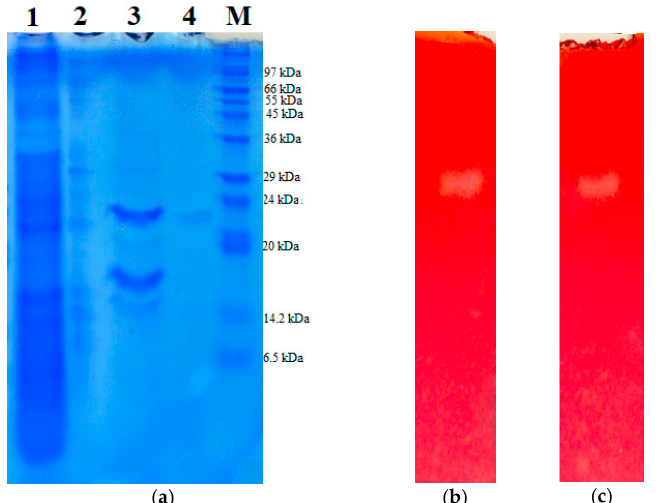
Figure 2. SDS-PAGE and zymogram profiles of Paenibacillus sp. TKU047 chitosanase. ( a ) SDS-PAGE; ( b ) Zymogram profile of culture supernatant; ( c ) Zymogram profile of purified Paenibacillus sp. TKU047